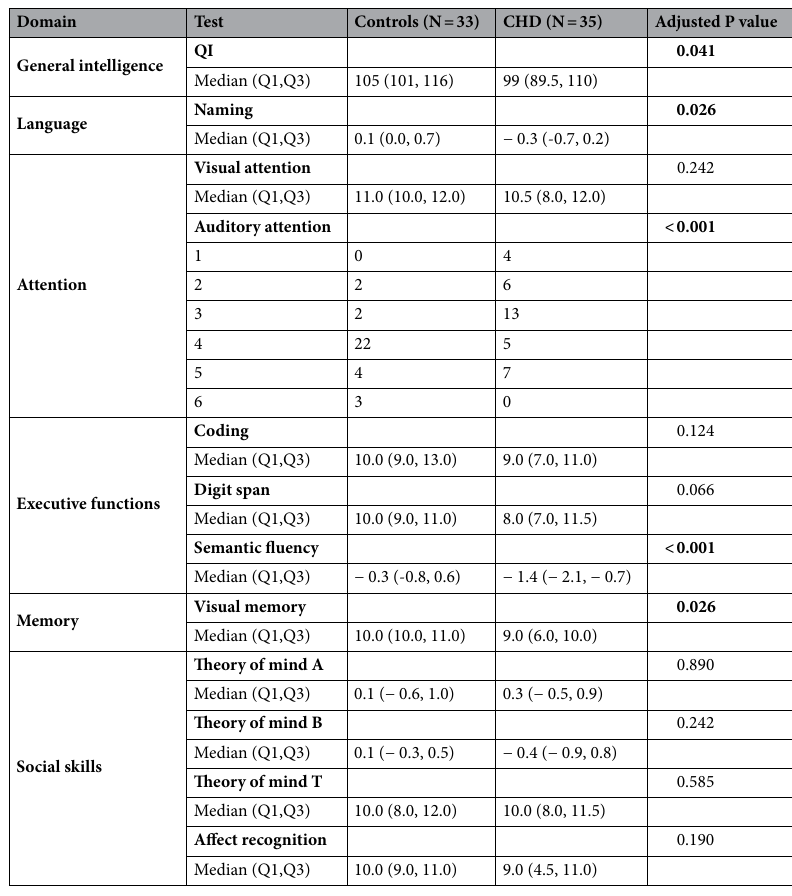
Table 2. Median and mean cognitive and neuropsychological scores obtained by the control and CHD